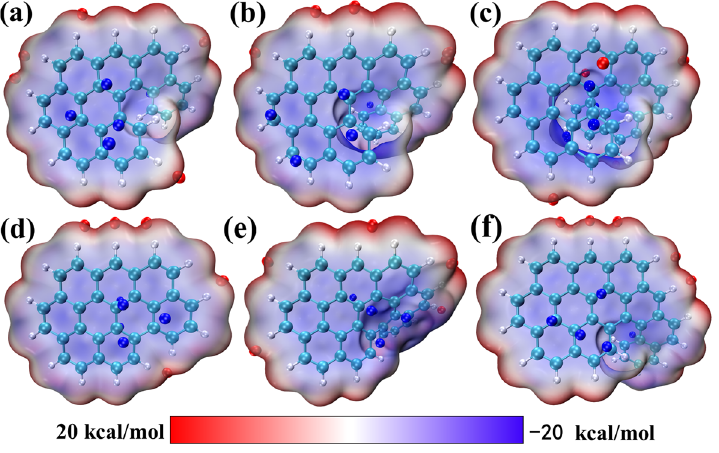
Figure 2. Electrostatic potential maps of 6 molecules: ( a ) O7H, ( b ) O8H, ( c ) O9H, ( d ) OO7H, ( e ) OO8H, and ( f ) OO9H.